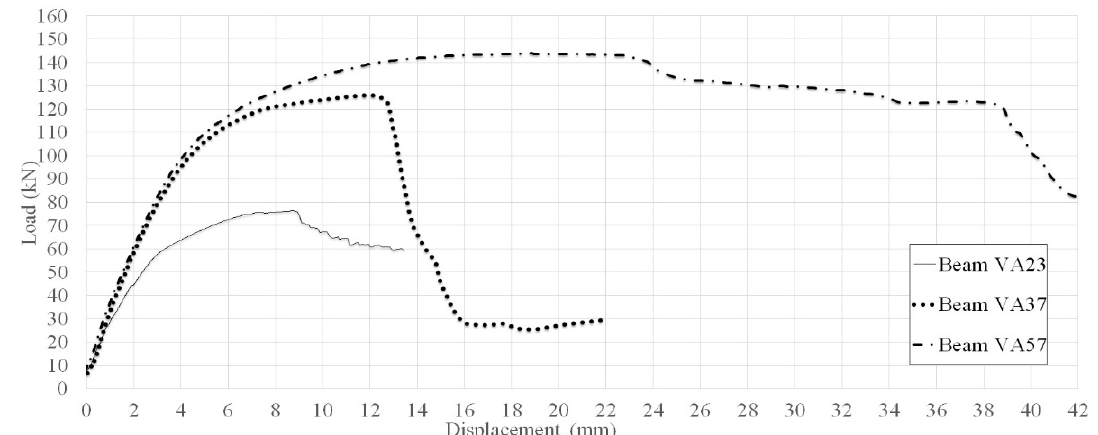
Figure 13. Load vs displacement curves - Beams reinforced with